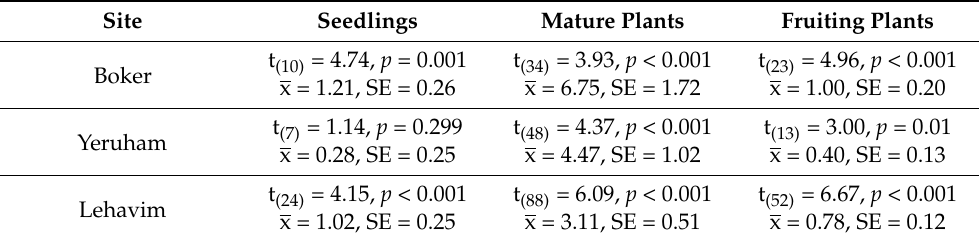
Table 1. Results of the paired-sampled t-tests for each life stage of S. clusiana in all three sites. For each plot containing a specific life stage, the t-test compares the number of individuals of the specific life stage occurring under shrub with the expected number of individuals at that life stage, assuming these are distributed in proportion to the shrub cover in that plot. In addition, means and standard errors of the difference between expected and observed are indicated. Site Seedlings Mature Plants Fruiting Plants t (10) = 4.74, p = 0.001 t (34) = 3.93, p < 0.001 t (23) = 4.96, p < 0.001 Boker x = 1.21, SE = 0.26 x = 6.75, SE = 1.72 x = 1.00, SE = 0.20 t (7) = 1.14, p = 0.299 t (48) = 4.37, p < 0.001 t (13) = 3.00, p = 0.01 Yeruham x = 0.28, SE = 0.25 x = 4.47, SE = 1.02 x = 0.40, SE = 0.13 t (24) = 4.15, p < 0.001 t (88) = 6.09, p < 0.001 t (52) = 6.67, p < 0.001 Lehavim x = 1.02, SE = 0.25 x = 3.11, SE = 0.51 x = 0.78, SE =